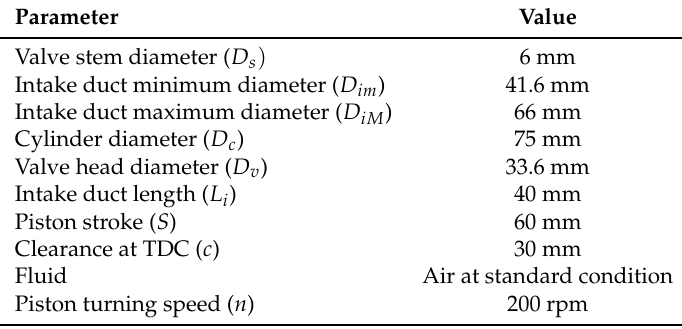
Table 4. Dimensions and flow parameters for the piston/cylinder simulation setup.